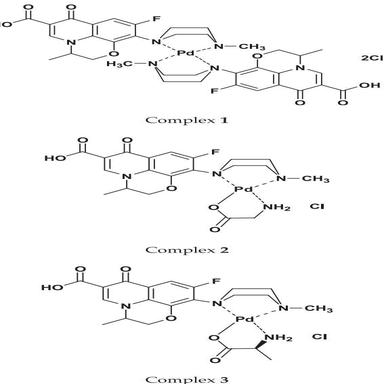
Proposed chemical structures of complexes 1, 2 and 3.